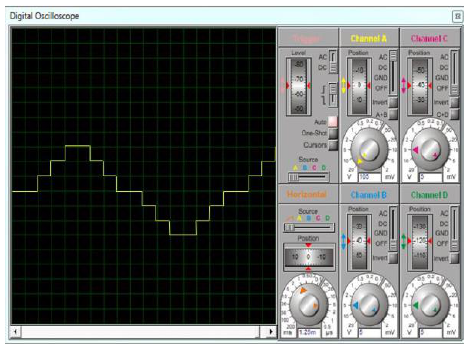
Figure 20 . Output Voltage for Modified 7-Level Inverter using Proteus